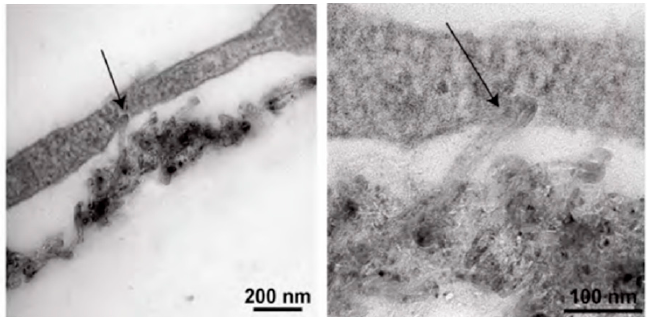
Figure 1. Carbon nanotube (CNT) interaction with cardiac myocyte membranes (arrows). The images show a tight interaction between the CNT and the cardiomyocyte cell membrane. Reprinted with permission from [43] Copyright 2012 American Chemical Society.